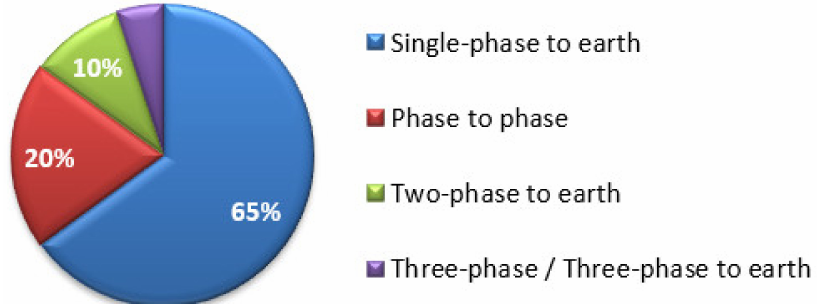
Figure 2. The short-circuit type participation in power supply system—data from